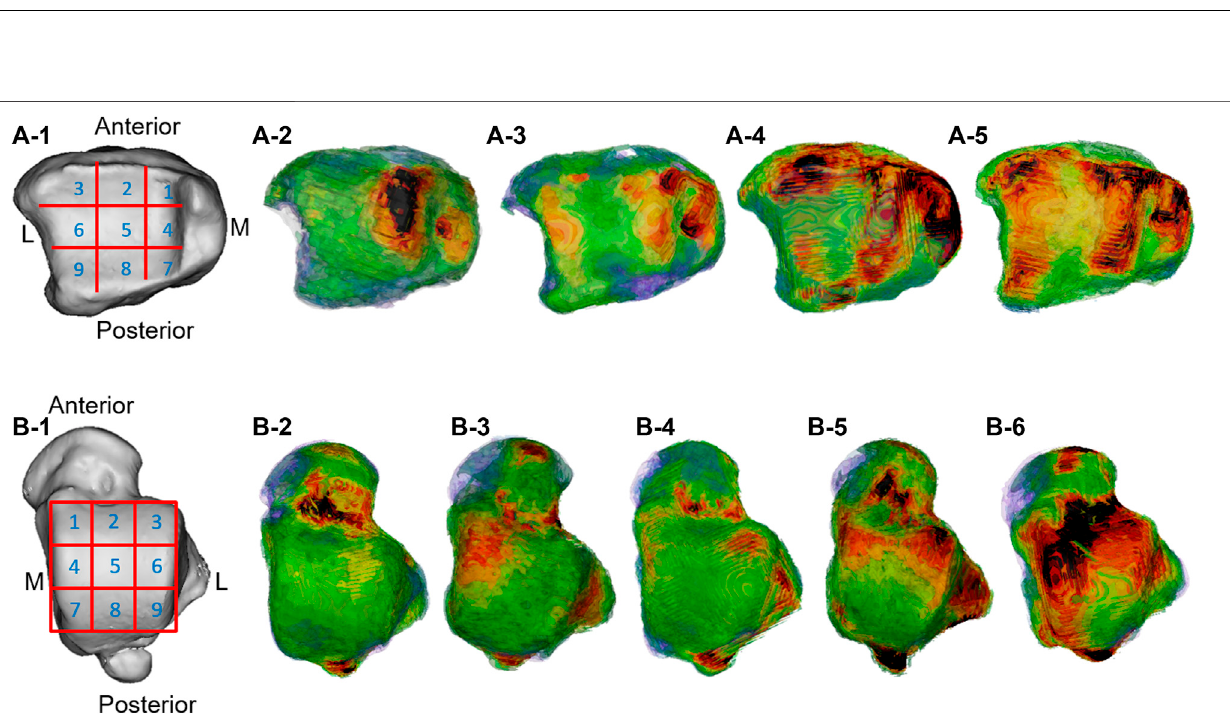
FIGURE 4 | Distribution pattern of the high-density zone of the distal tibial articular surface and talar talus. A-1 and B-1 are the division pattern of the high-density zone ofthedistal tibialarticular surfaceand talartalus; A-2wasthemedial center;A-3wasthemedial – lateralcenter; A-4wasthering;A-5wascomprehensive;B-2was blank; B-3 was the medial center; B-4 was lateral center; B-5 was medial – lateral center; B-6 was ring type.